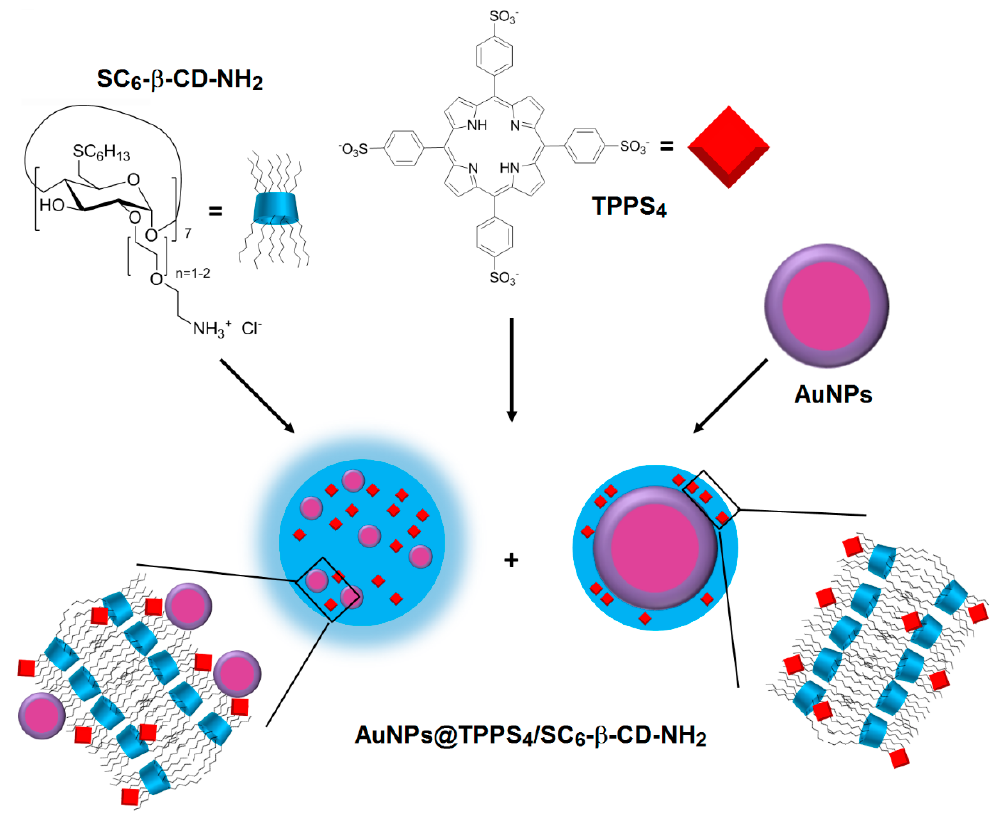
Figure 59. Sketch (not to scale) of the two typologies of ternary AuNPs@TPPS 4 /SC 6 - β -CD-NH 2 systems presumably formed in aqueous solution. Adapted from Trapani; Romeo; Parisi; Sciortino; Patane; Villari; Mazzaglia [197].